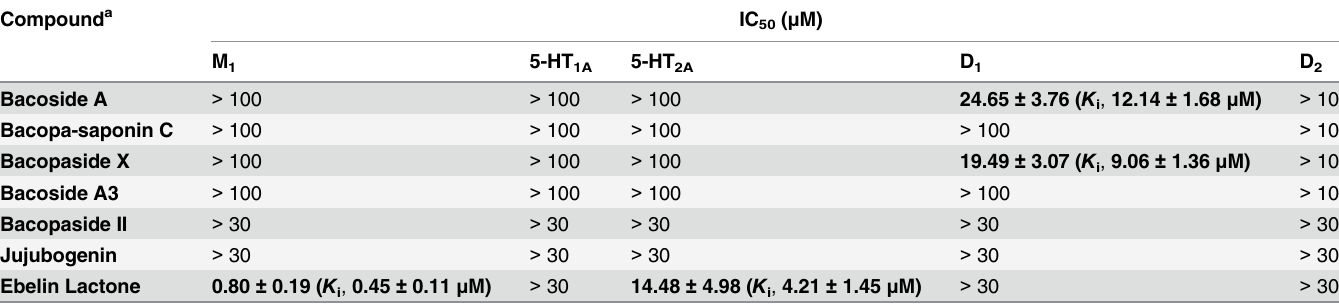
Table 4. CNS receptor binding affinities of bacosides and aglycones. Compound a